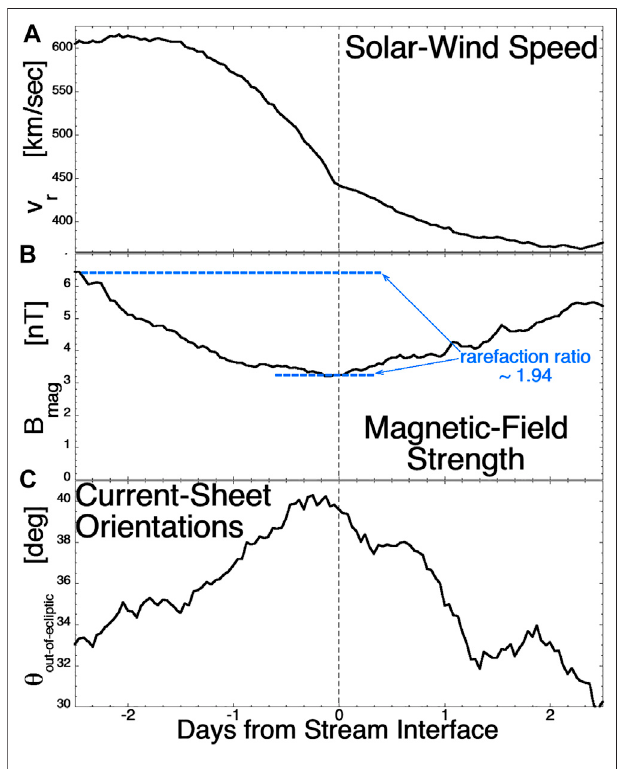
FIGURE 6 | Superposed epoch averages of ACE measurements of 27 corotating interaction regions at 1 AU. Panel (A) plots the solar-wind speed, panel (B) plotsthemagnetic- fi eldstrength,andpanel (C) plotsthemeanvalue of the angle between the normals of observed current sheets in the plasma and the ecliptic plane.